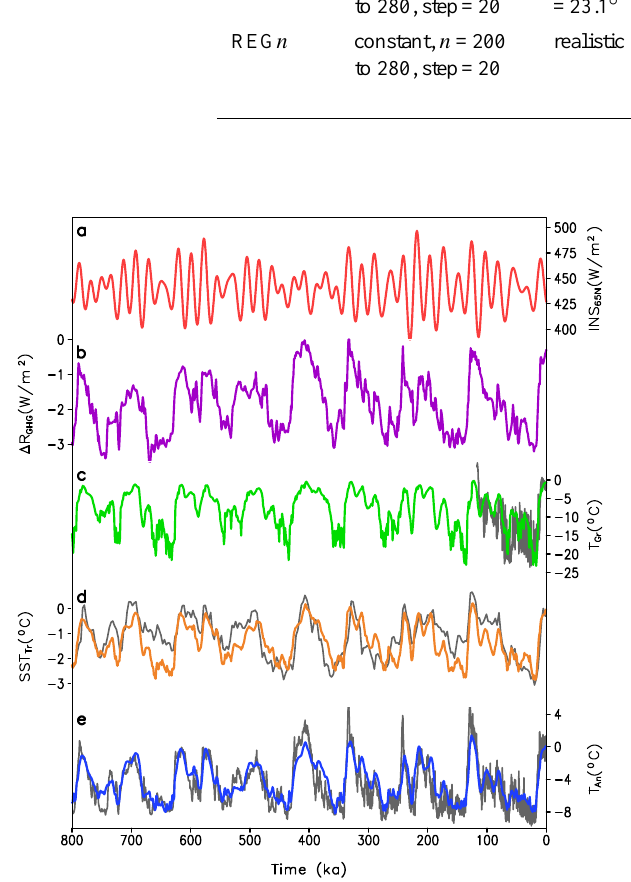
Fig. 1. (a) Maximum summer insolation at 65 ◦ N; (b) radia- tive forcing of prescribed equivalent CO 2 concentration; (c) sim- ulated (green) versus reconstructed (grey) Greenland temperature anomaly; (d) simulated (orange) versus reconstructed (grey) tropi- cal SST anomaly, (e) simulated (blue) versus reconstructed (grey) Antarctic temperature anomaly.